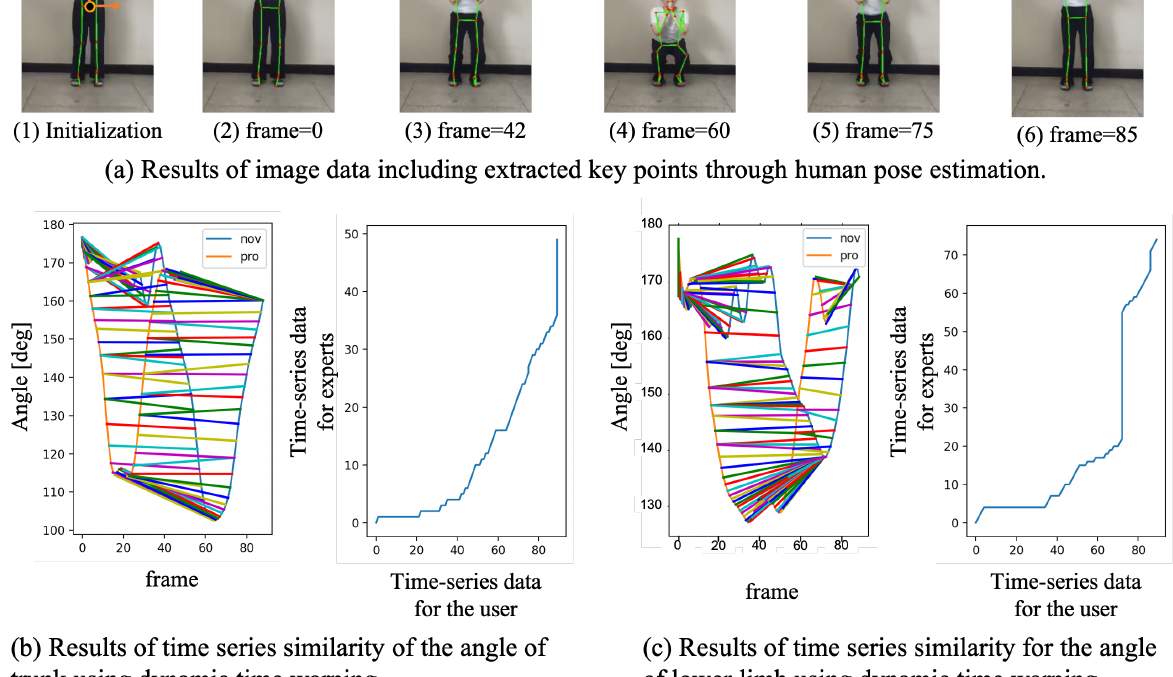
Figure 12. Results of similarity in time series data through dynamic time warping (DTW). ( a ) represents image data including extracted key points through human pose estimation, and ( b , c ) represent similarity in time series data for angles of the trunk and lower limbs,